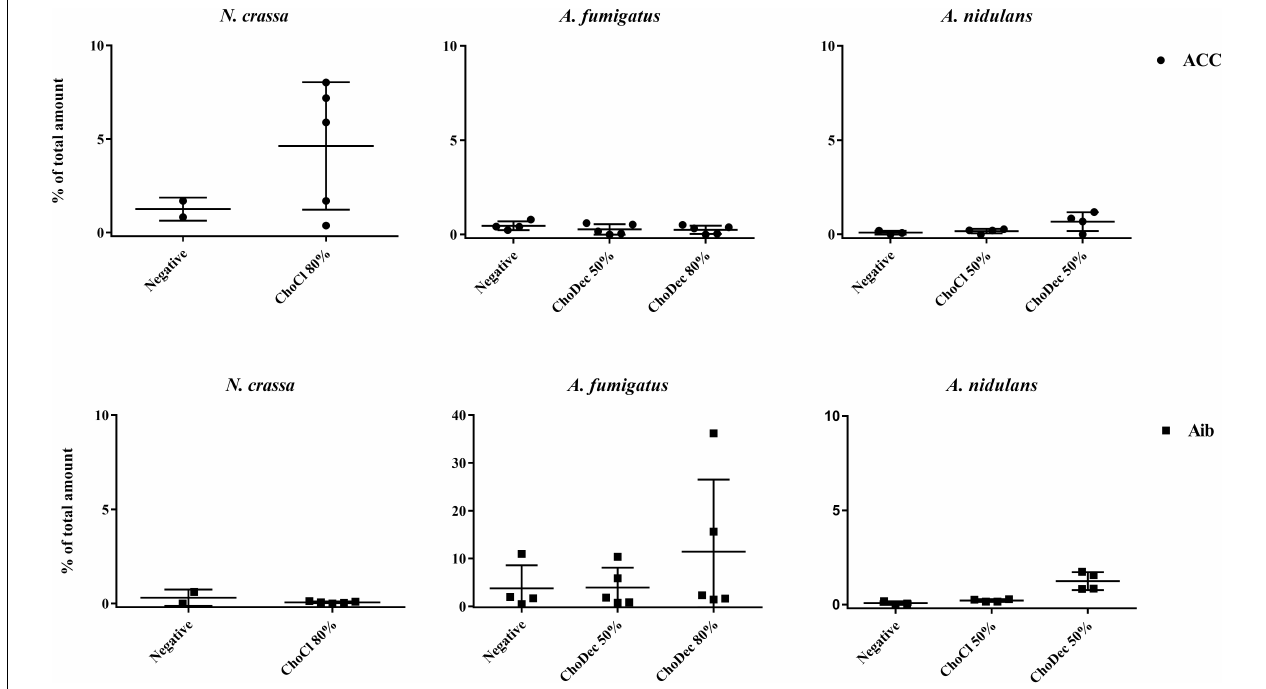
FIGURE 2 | Total amino acid hydrolysis discloses the presence of two non-proteinogenic residues in N. crassa and A. fumigatus extracts. Scatter plot depicting individual values of percentage (%) of total amount of 1-aminocyclopropane-1-carboxylate, ACC ( • ) and α -aminoisobutyric acid, Aib ( (cid:4) ) obtained from total hydrolysis of the crude extracts derived from cultures grown in media with or without (i.e., negative) supplementation. The y -axis scales are not normalized to allow easier visualization of the amount of either non-proteinogenic amino acid in each